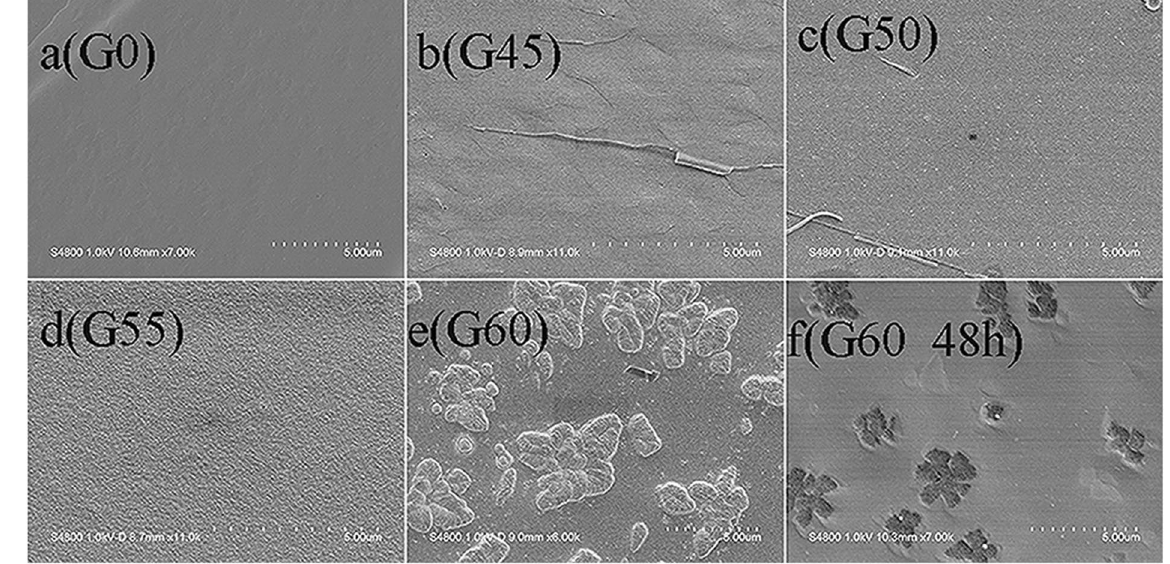
Figure 4. Secondary electron SEM images of all samples untreated ( a )–( e ) and of G60 treated in 0.1 M KNO 3 electrolyte for 48 hrs ( f ).